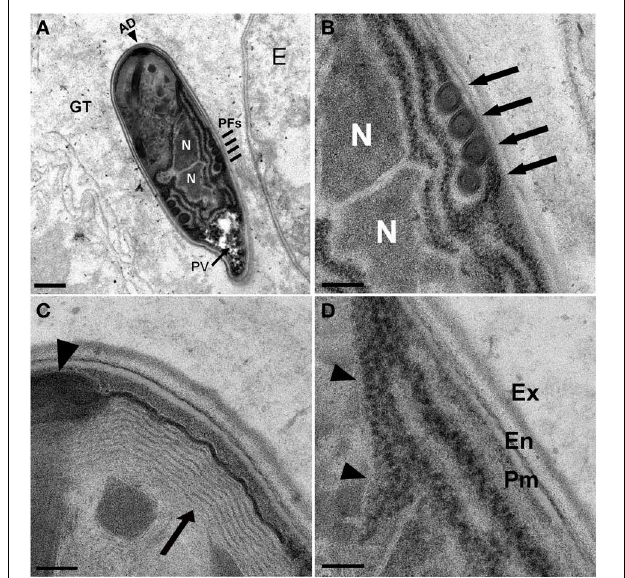
FIGURE 5 | N. marisprofundi spore morphology. (A–D) TEM micrographs of 70nm longitudinal cross sections showing N. marisprofundi spore morphology. (A) Whole mature spore with a typical coils of the polar filaments. Coil number varies between three and five ( n = 15 spores imaged), no spore dimorphism has been observed. PV, posterior vacuole (arrow); N, nucleus; PFs, four coils of the polar filaments (lines); AD, anterior disc (arrowhead), GT genital tract. (B) A close up of the central region showing the two nuclei (N) and four isofilar polar filament coils (arrows) (C) The lamellar polaroplast (arrow) underneath the anchoring disc (arrowhead) at the anterior end of the spore. (D) Exospore (Ex) Endospore (En), plasma membrane (Pm) at the spore periphery, and a row of ribosomes adjacent to a nucleus (arrowheads). Nomenclature of spore components is based on (Vavra and Larsson, 1999). Scale bars are 1 µ m (A) ; 200nm (B) ; 100nm (C,D)